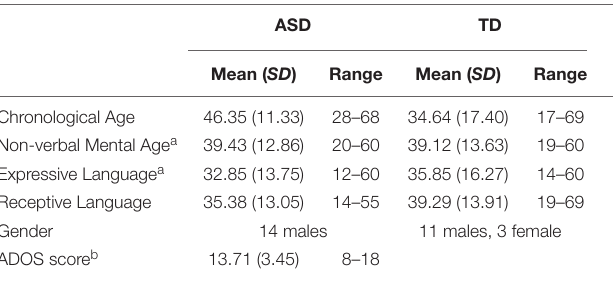
TABLE 1 | Participant sample